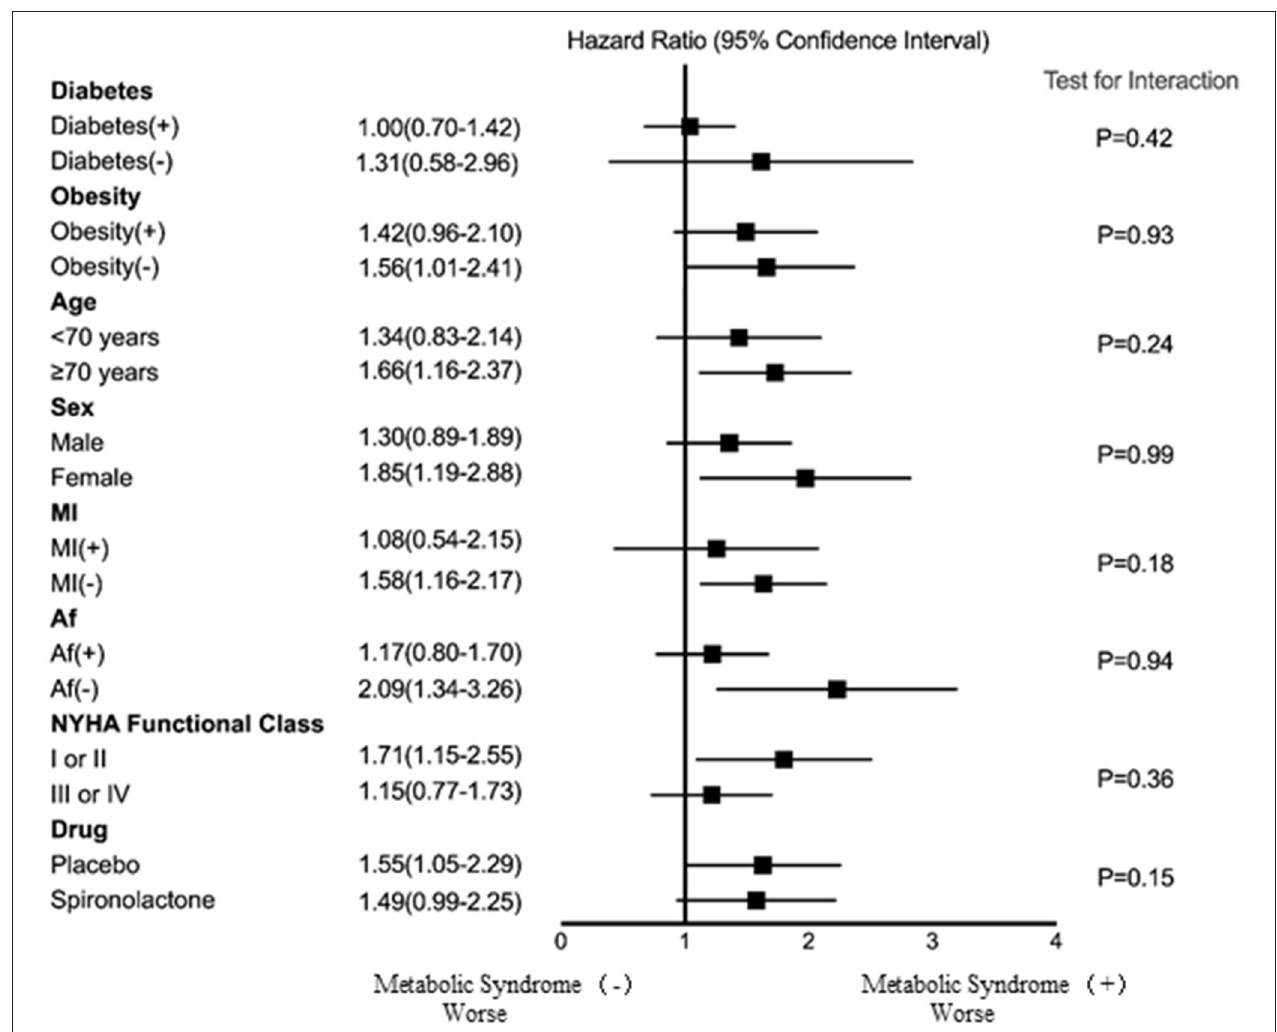
FIGURE 4 | The association between metabolic syndrome and risk of HF hospitalization for the different subgroups. Af, atrial fibrillation; MI, myocardial infarction; NYHA, New York Heart